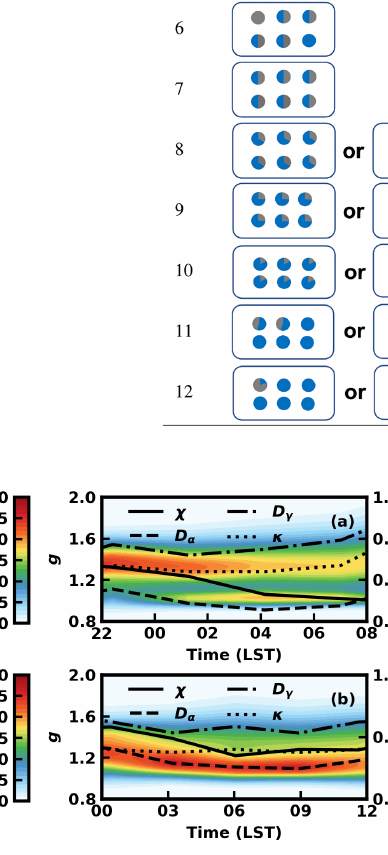
Figure 3. The variation of κ -PDF, D α , D γ , and χ during two typ- ical evolution processes for 110nm aerosols with tiny changes of κ mean on 23 January 2019 (a) and 27 January 2019 (b)